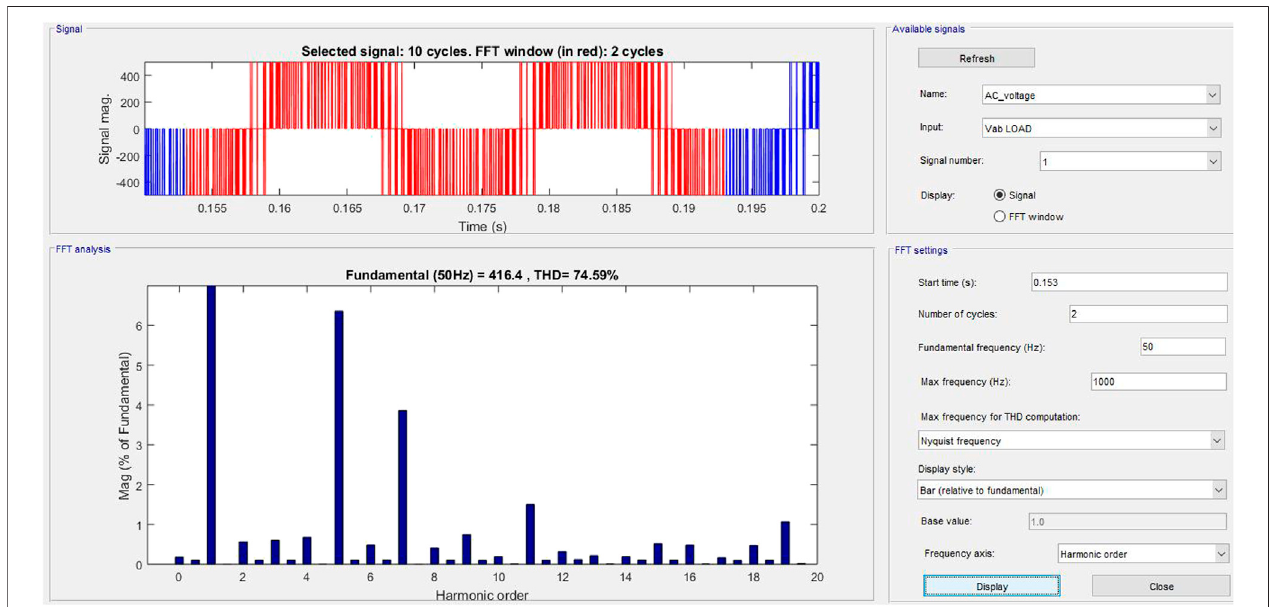
FIGURE 3 | Harmonic distortion before fi